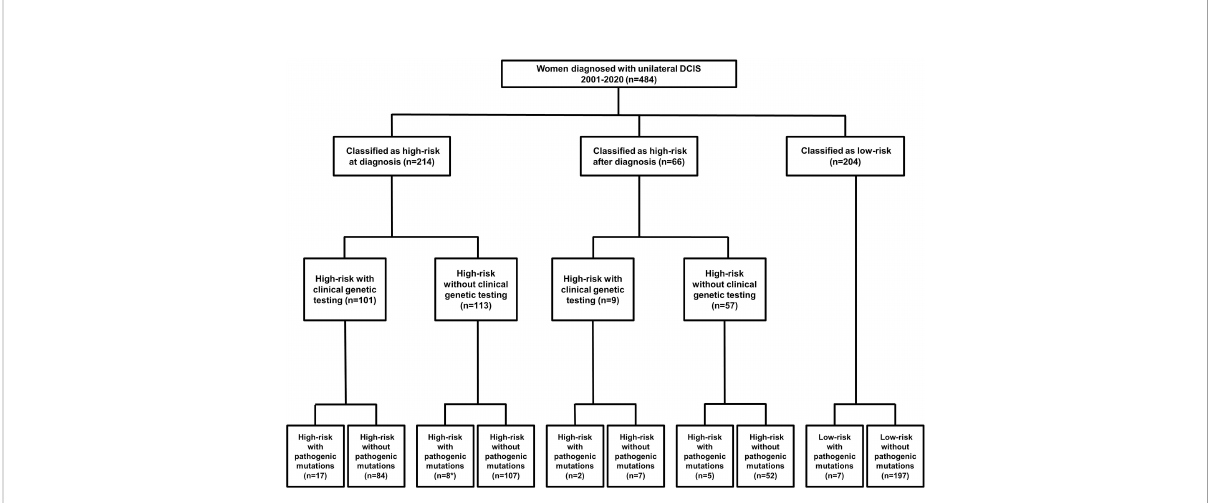
TABLE 1 Demographic and clinical information for all patients classi fi ed as high-risk at the time of diagnosis, high-risk after diagnosis or low-risk using NCCN criteria. High-risk at diagnosis (n=214) High-risk after diagnosis (n=66) p-value a Low-risk (n=204) p-value b